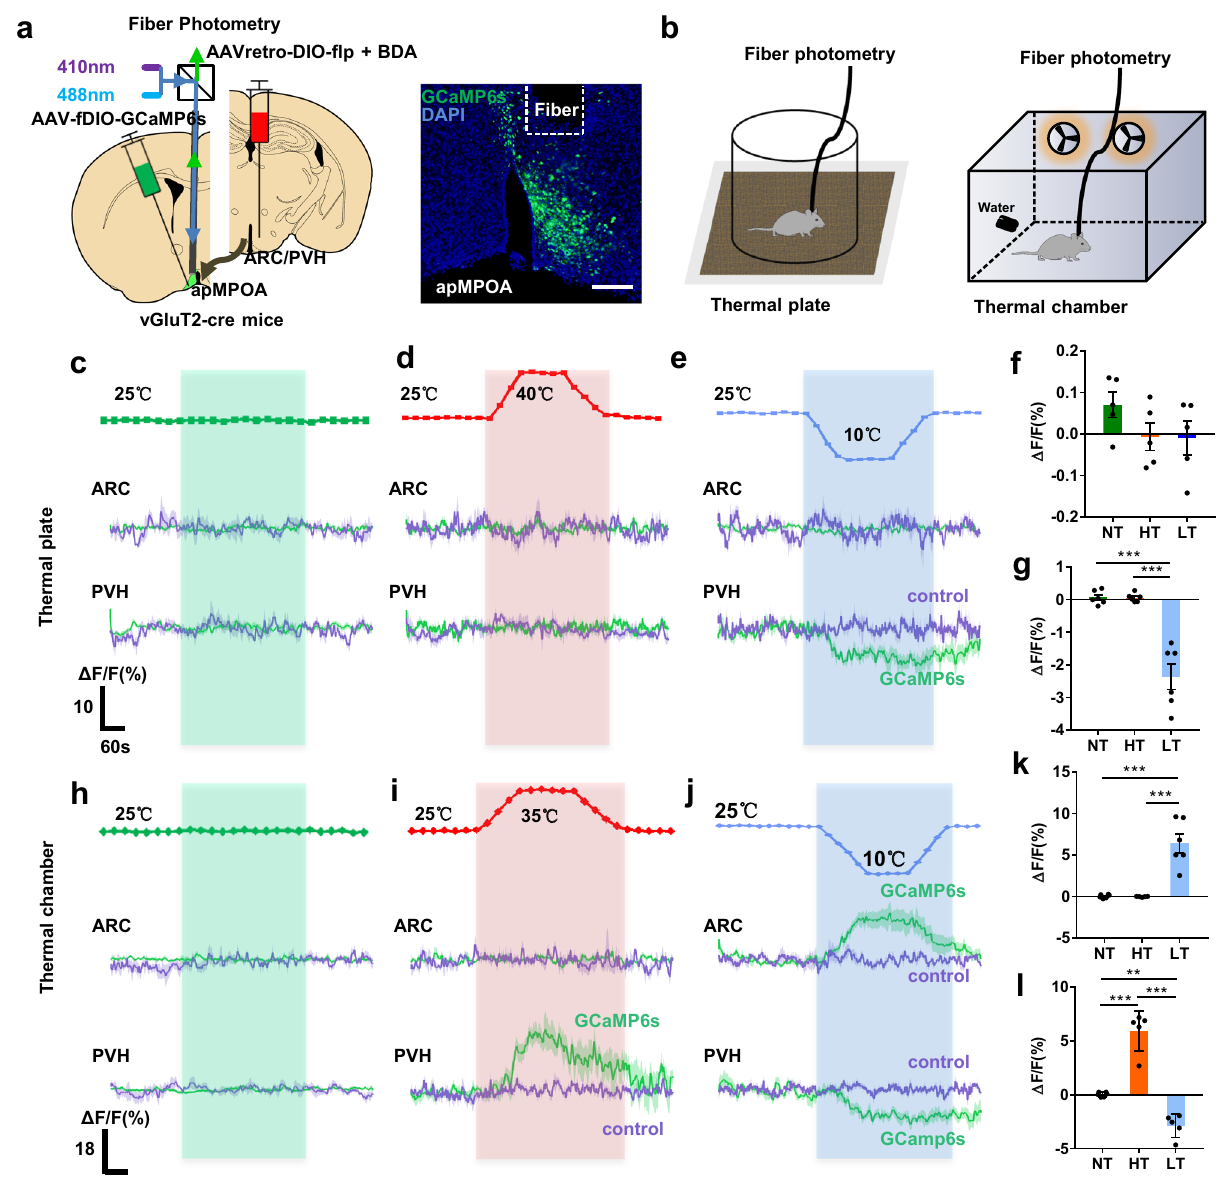
Fig. 6 PVH and ARC-projecting apMPOA neurons are responsive to ambient thermal exposure, but not to local stimuli. a Schematic and representative coronal images of AAVretro-DIO- fl p virus injection into the PVH and ARC (ARC shown here) and AAV-fDIO-GCaMP6s into the apMPOA in vGluT2-cre mice. The optical fi ber was placed 200 µ m above the apMPOA neurons. Red fl uorescent BDA (biotinylated dextran amines) was mixed into the virus to indicate the injection range. Image representative of n = 12 mice. Scale bar, 100 µ m. b Schematic of thermal exposure by temperature-controlled plate and chamber. c – e GcaMP6s (mean, green line; SEM, green shading) and control (mean, purple line; SEM, purple shading) signal changes ( Δ F/F%) of the ARC (top) and PVH-projecting (bottom) apMPOA neurons in response to local thermal stimuli: neutral (25 °C, green dotted line in Fig. 6c), hot (25 °C → 40 °C, red dotted line in Fig. 6d), cold (25 °C → 10 °C, blue dotted line in Fig. 6e). h – j GcaMP6s (mean, green line; SEM, green shading) and control (mean, purple line; SEM, purple shading) signal changes ( Δ F / F %) of the ARC (top) and PVH-projecting (bottom) apMPOA neurons in response to ambient thermal exposure: neutral (25 °C, green dotted line in Fig. 6h), hot (25 °C → 35 °C, red dotted line in Fig. 6i), cold (25 °C → 10 °C, blue dotted line in Fig. 6j). Bar graphs show mean Δ F/F response of ARC (thermal plate: f thermal chamber: k ) and PVH-projecting (thermal plate: g thermal chamber: l ) apMPOA neurons in a 5 min window after the onset of thermal exposure. One-way repeated-measure ANOVA and post hoc LSD multiple comparison, g all *** p < 0.001, k all *** p < 0.001, l : ** p = 0.002, *** p < 0.001. n = 6 for both PVH and ARC groups, but n = 5 animals were included into statistical ANOVA in ARC groups in cold plate and hot chamber, PVH group in cold chamber and hot chamber due to incomplete data. All error bars show